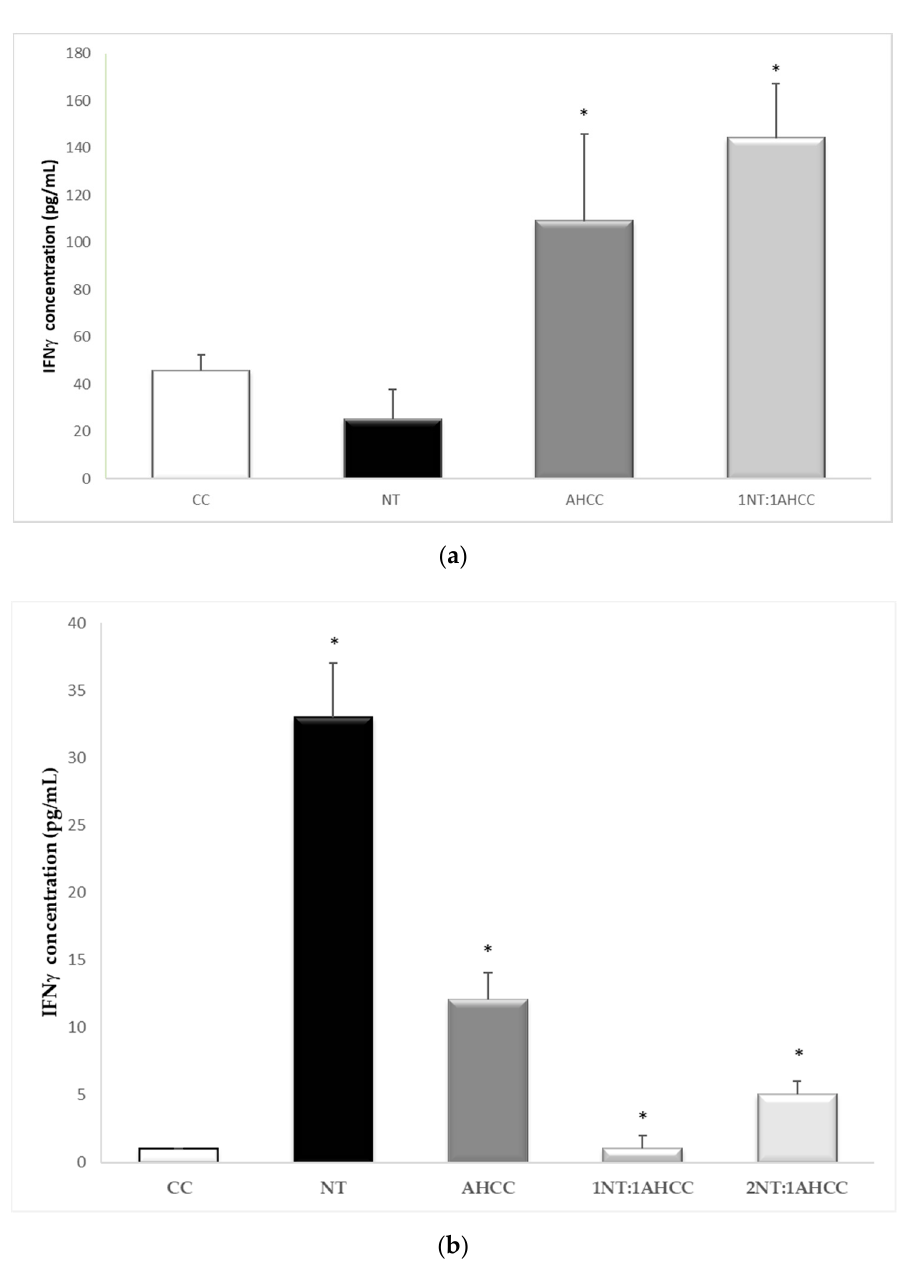
Figure 5. IFN- γ determination after exposure to nucleotides (NTs) and AHCC, alone or in combination, in L . infantum -infected macrophages ( a ) and L. infantum -infected macrophage/lymphocyte cocultures ( b ). * p < 0.05 versus the control.